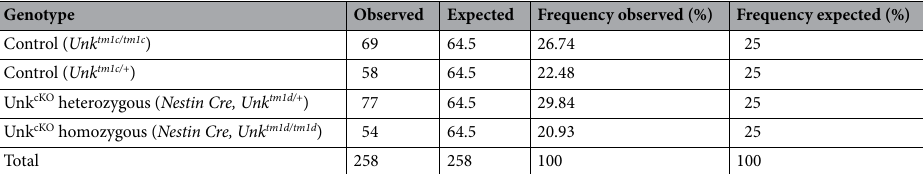
Table 1. Unk cKO mice are born at expected Mendelian ratios. The table shows the number of pups born for each genotype, from 32 litters. Statistical significance was calculated with Pearson’s Chi-square test, Chi-square value = 5.1, p = 0.165.